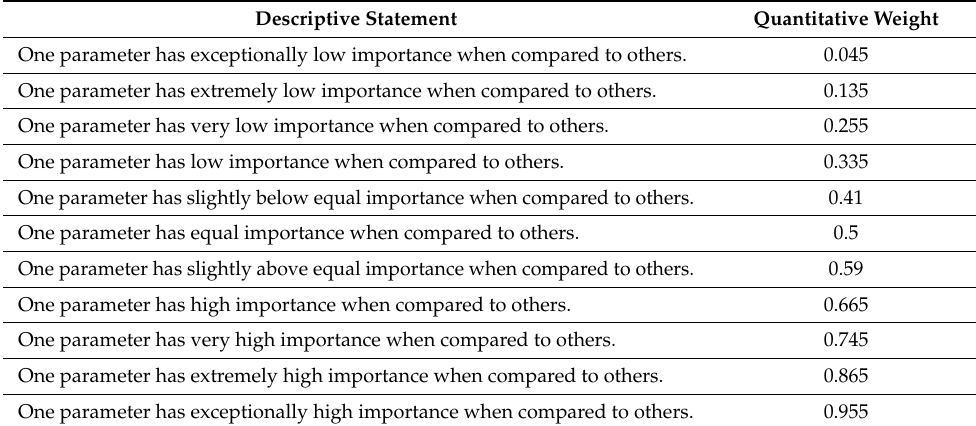
Table 7. 11-point fuzzy logic